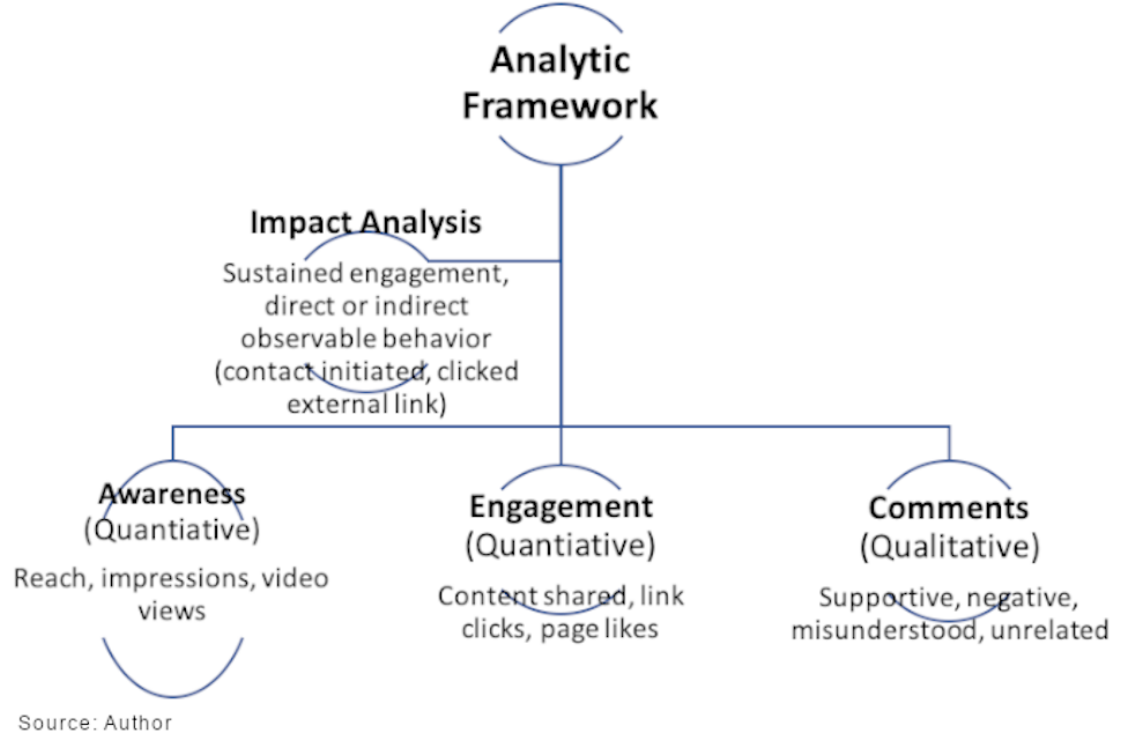
Figure 1. Data analysis framework.